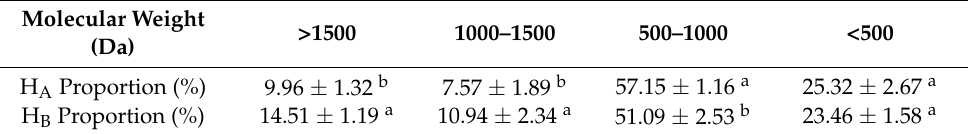
Table 2. Comparison of the molecular weight distribution for enzymatic hydrolysates with differ- ent